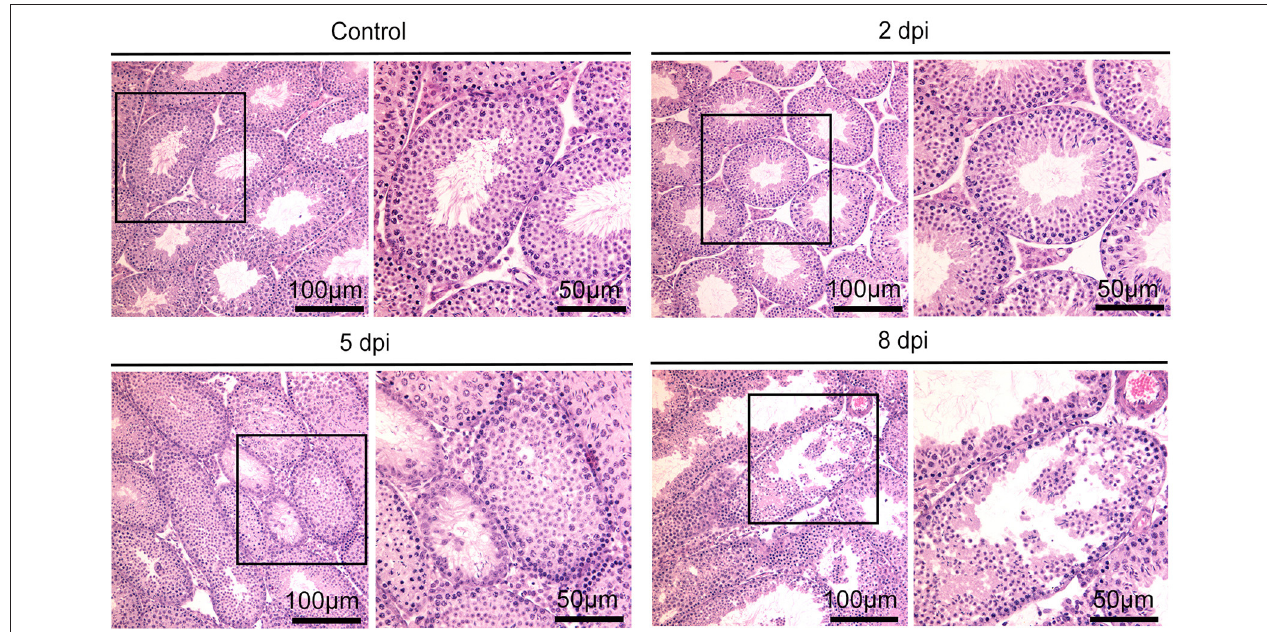
FIGURE 3 | Histopathological changes of testis in ZIKV-infected mice at different time points as indicated or control mice.